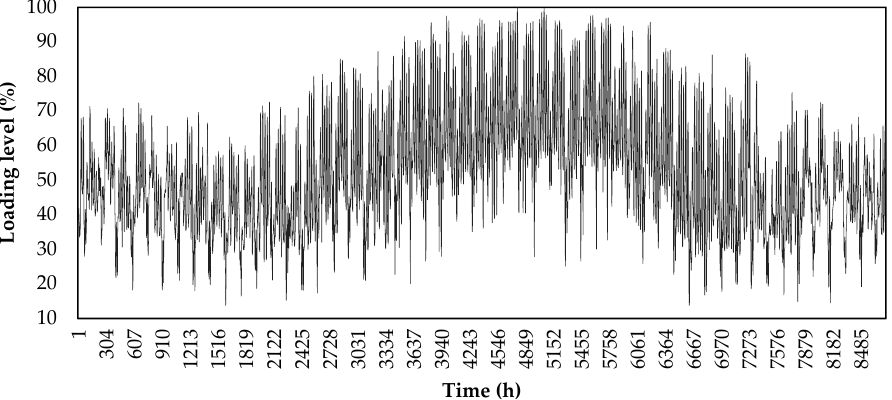
Figure 6. Load profile over one year.